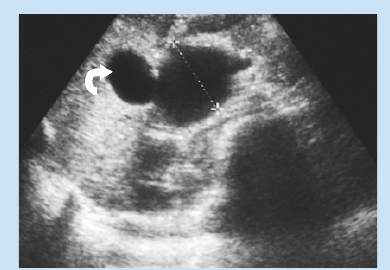
Fig.1a. Coronal ultrasound through the liver and common bile duct. The dilated bile duct (curved arrow) appears to communicate with a large anechoic cystic collection in the pancre- atic head.